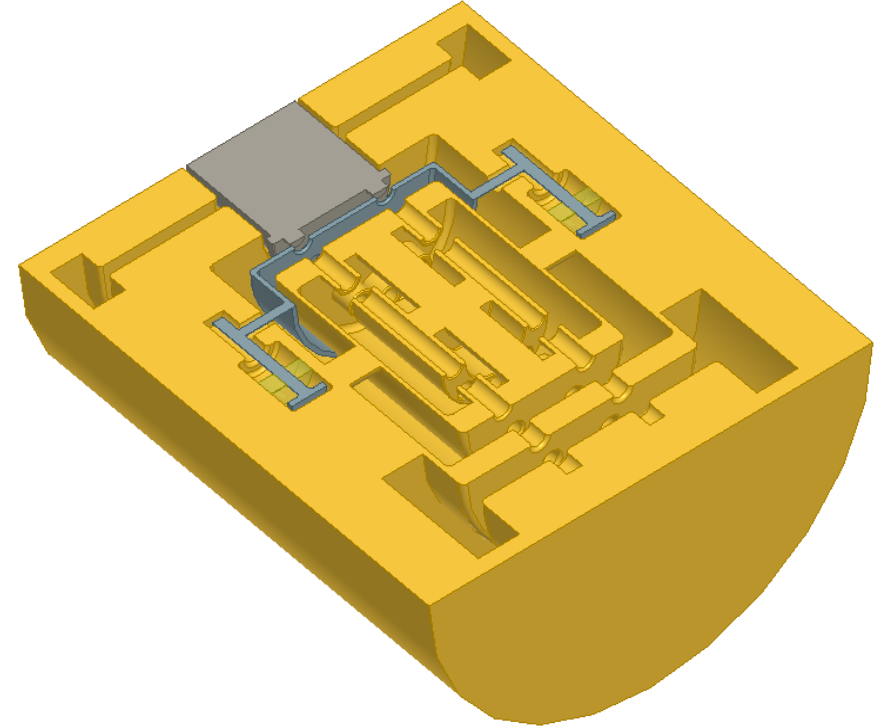
Figure 23. A 3D model of a resotrode with 2 π -regeneration .